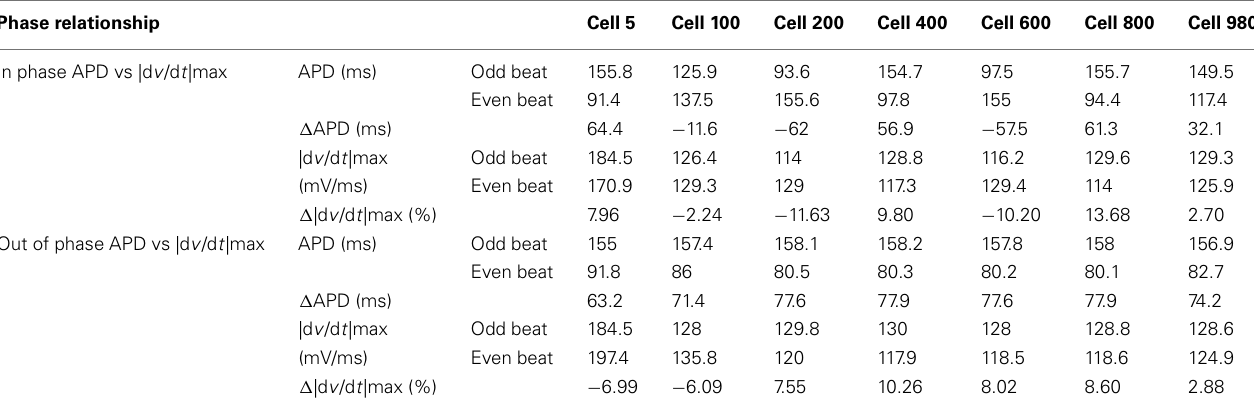
Table 1 | Summary of results of simulated activations.